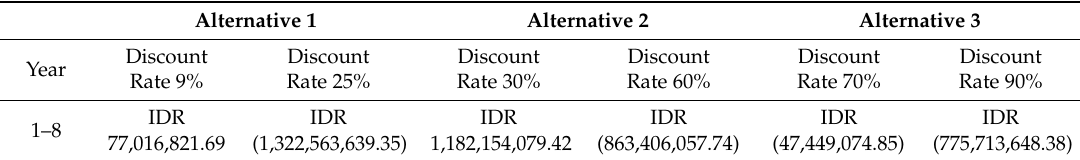
Table 9. NPV1 and NPV2